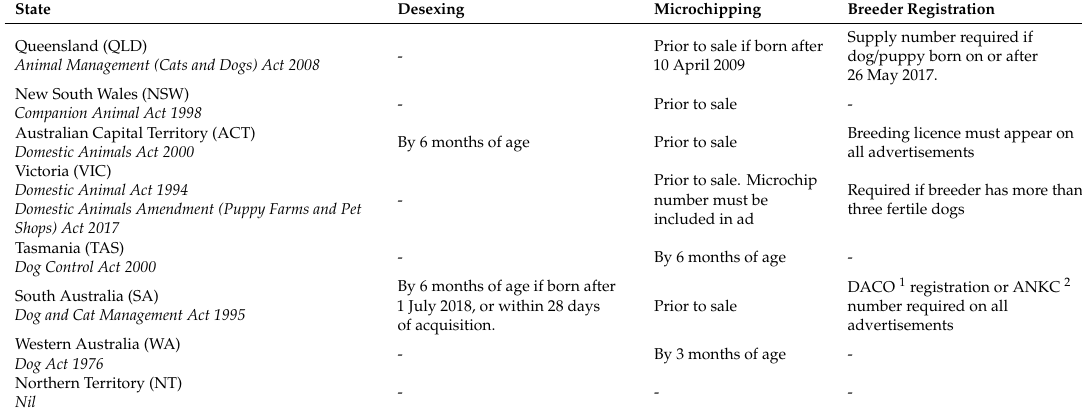
Table 1. Regulations for dog and puppy trade (including online) per state and territory in Australia as of 25 March